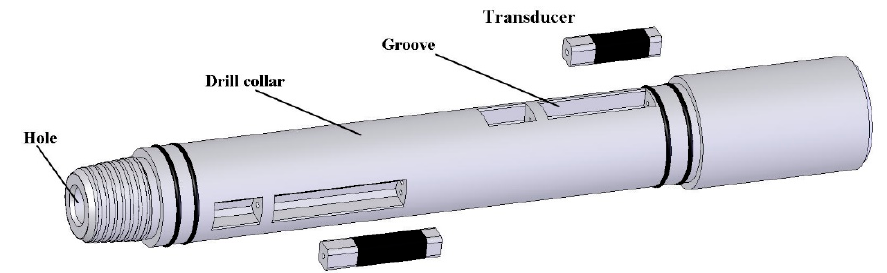
Figure 1. The schematic diagram of a drill collar with a groove to assemble the transducer. Many types of transducer, such as Tonpilz transducers, flextensional transducers, flexural transducers, Piezoelectric rings, magnetostrictive transducers, piezoelectric